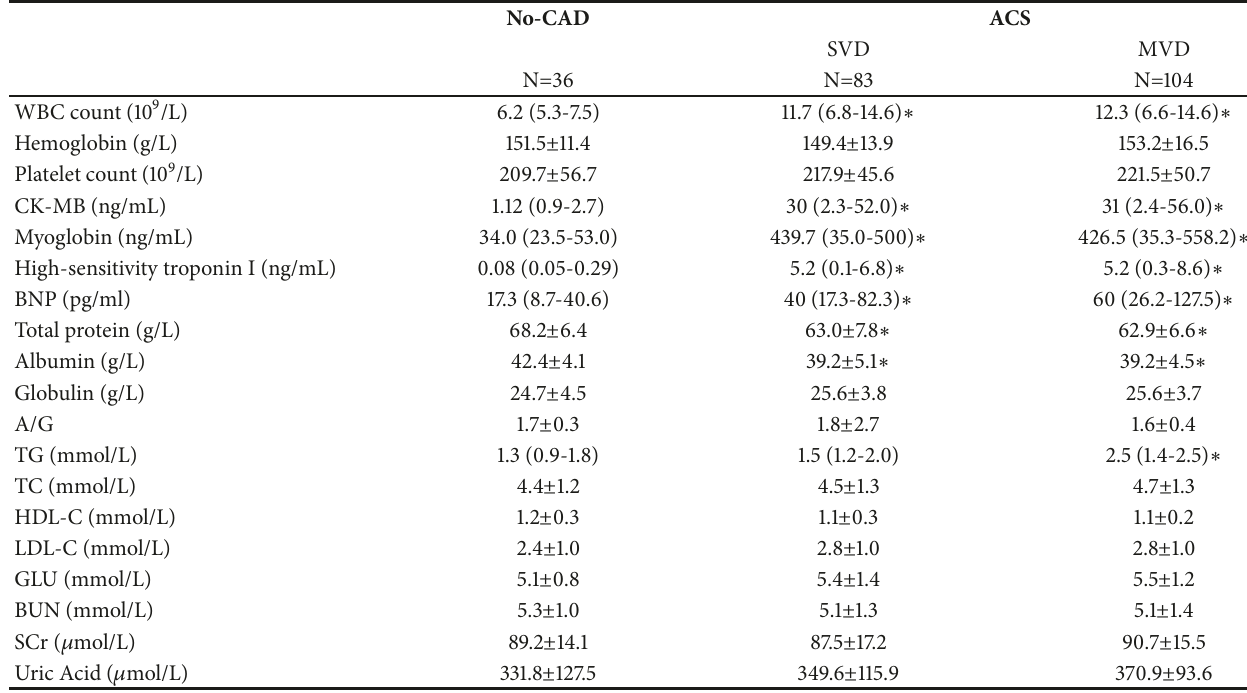
Table 2: Laboratory findings.